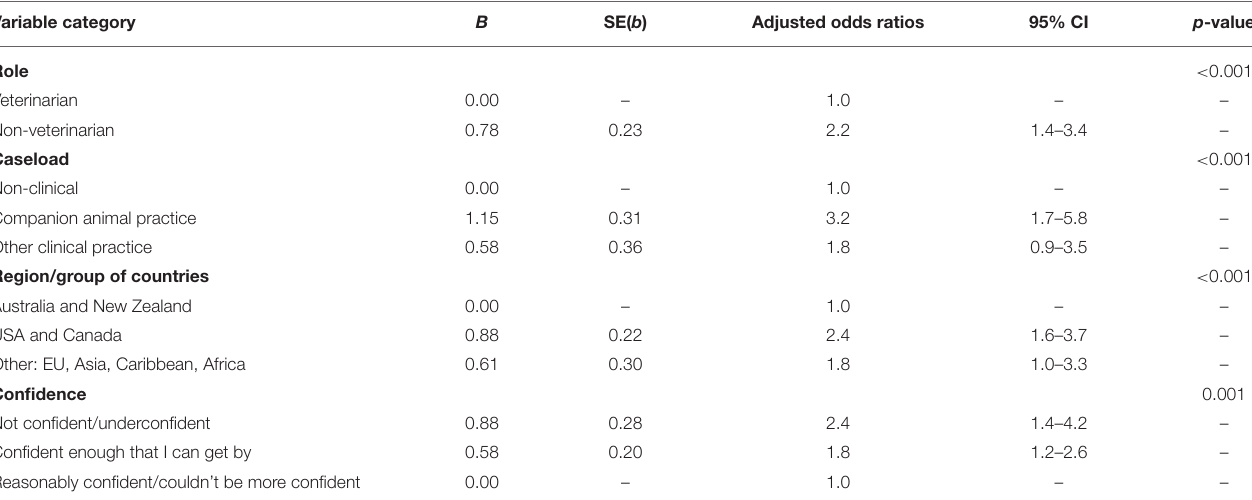
TABLE 4 | Final binary multivariable logistic regression model of risk factors for an increase in ethically challenging situations encountered, in a global survey of veterinary team members at the advent of the COVID-19 pandemic (May-July 2020) ( n = 540). Variable